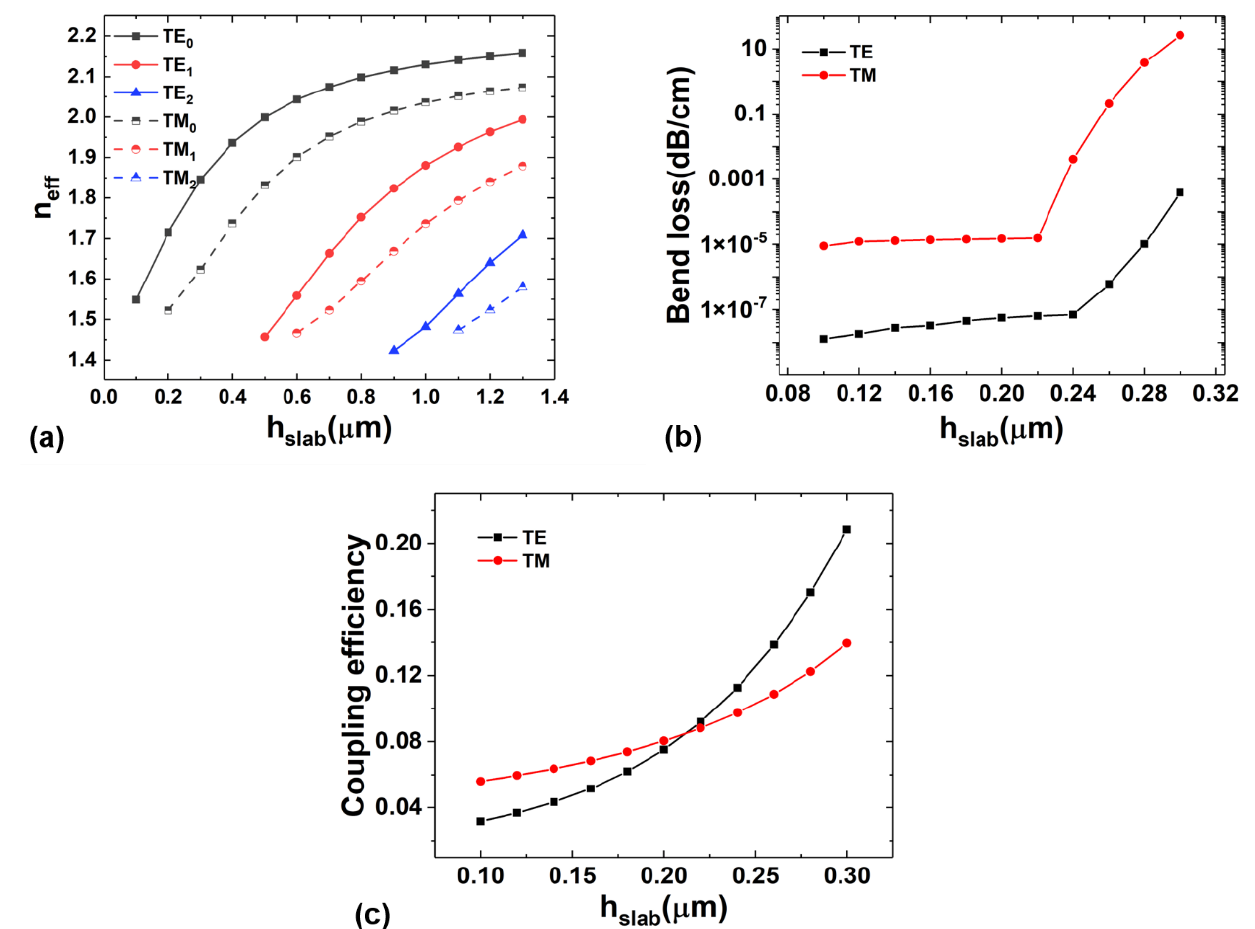
Figure 2. ( a ) Relationship between effective refractive index of lithium niobate-on-insulator (LNOI) slab waveguide with 1 μm upper cladding thickness and slab thickness. ( b ) The influence of the thickness of LN slab layer on bending loss with the waveguide width of 0.8 μm and the bending radius of 100 μm. ( c ) The dependence of the coupling efficiency and the thickness of the lithium niobate (LN) slab layer with coupling distance gap = 0.5 μm.